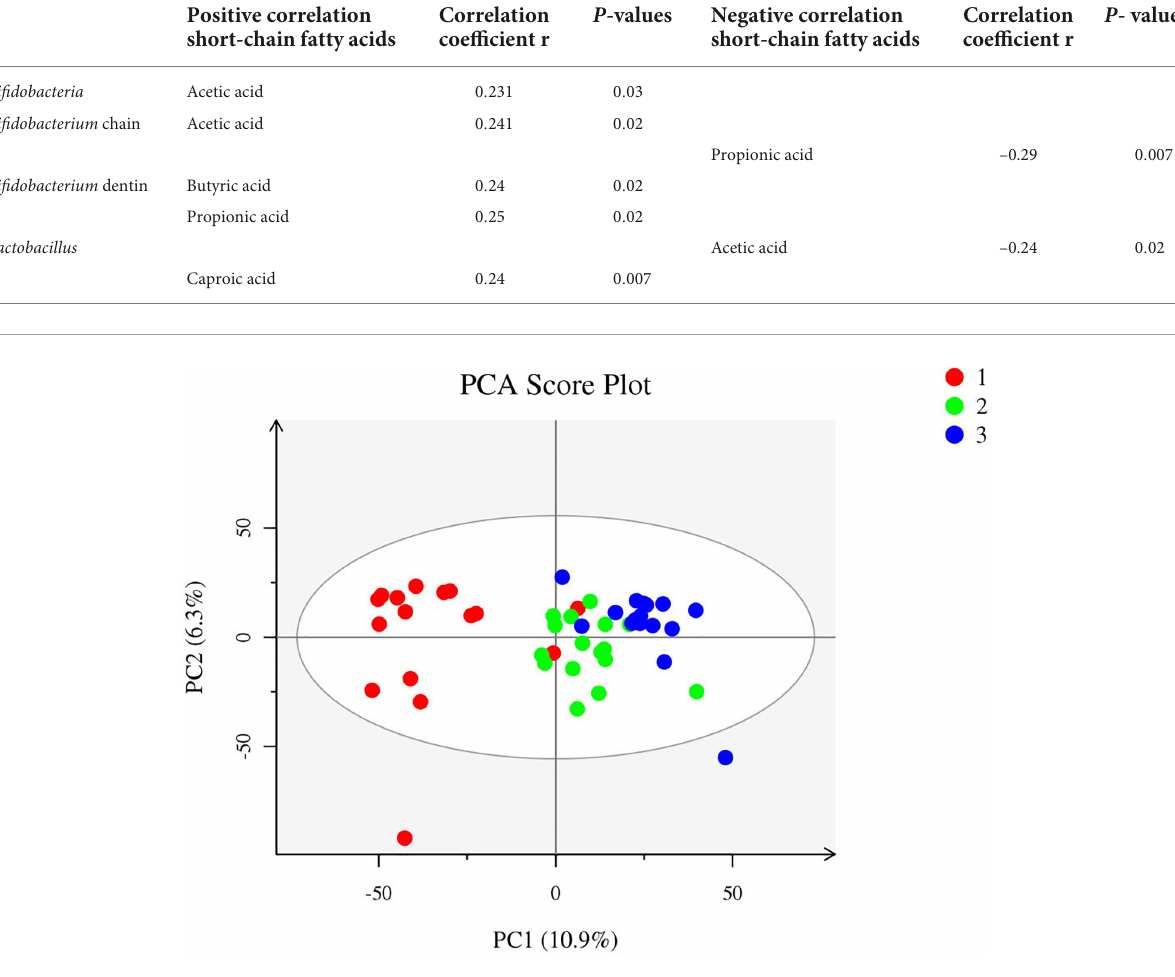
TABLE 3 Correlation analysis between probiotics and short-chain fatty acids.